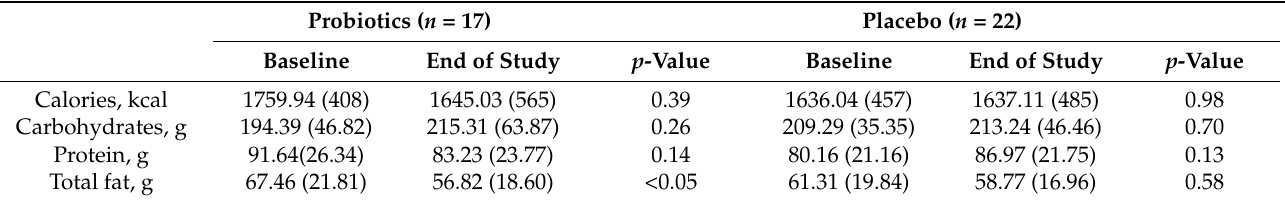
Table 5. Dietary intake from baseline to the end of the study within the